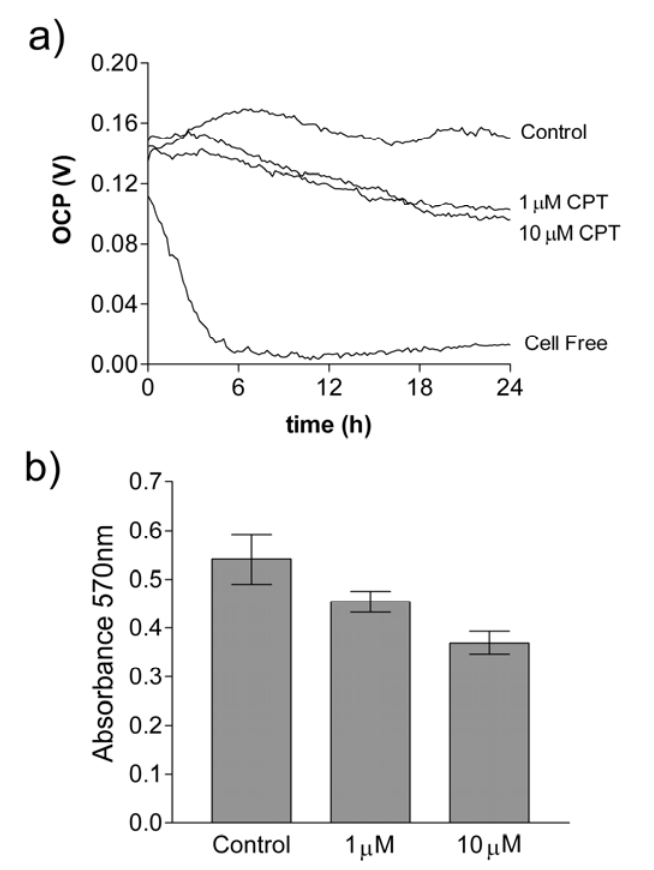
Figure 5. (a) Real-time electrochemical monitoring of the effect of camptothecin (CPT) on the OCP of HepG2 cells over 24 h (n = 6). (b) MTT assay data (absorbance ± SEM) from CPT treated HepG2 cells in parallel cultures after 24h (n =